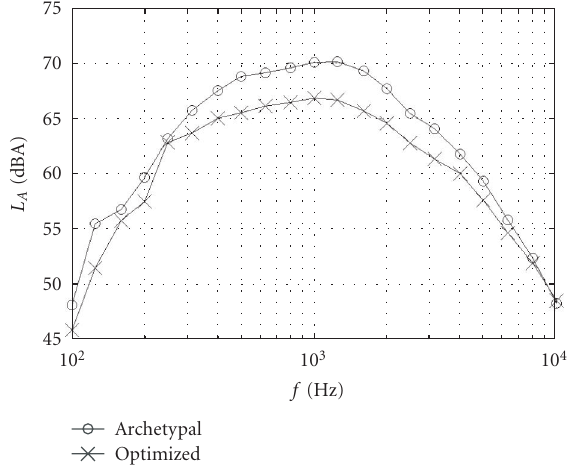
Figure 14: Spanwise distribution of total pressure rise.